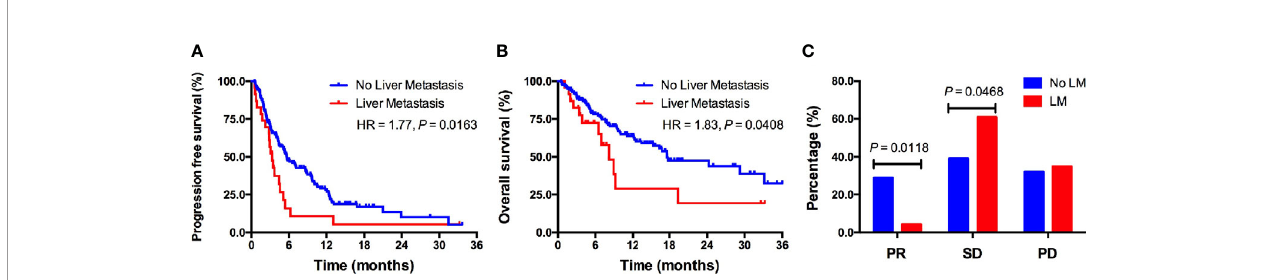
FIGURE 2 | The predictive value of LM for ICIs treatment outcomes in a real-world cohort. (A) Kaplan – Meier curve of PFS in patients with versus without LM; (B) Kaplan – Meier curve of OS in patients with versus without LM; (C) Response rate comparison between patients with versus without LM. LM, liver metastasis; PR, partial response; SD, stable disease; PD, disease progression.